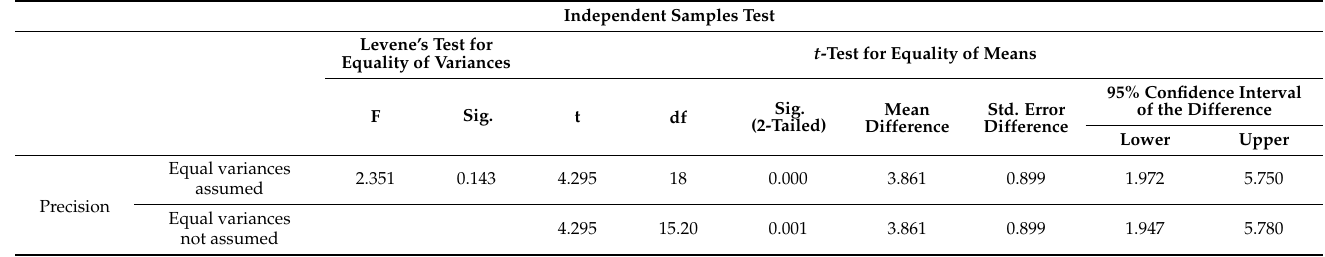
Table 8. Comparison of independent samples t -test parameters of EDRL and CNN algorithms for precision.